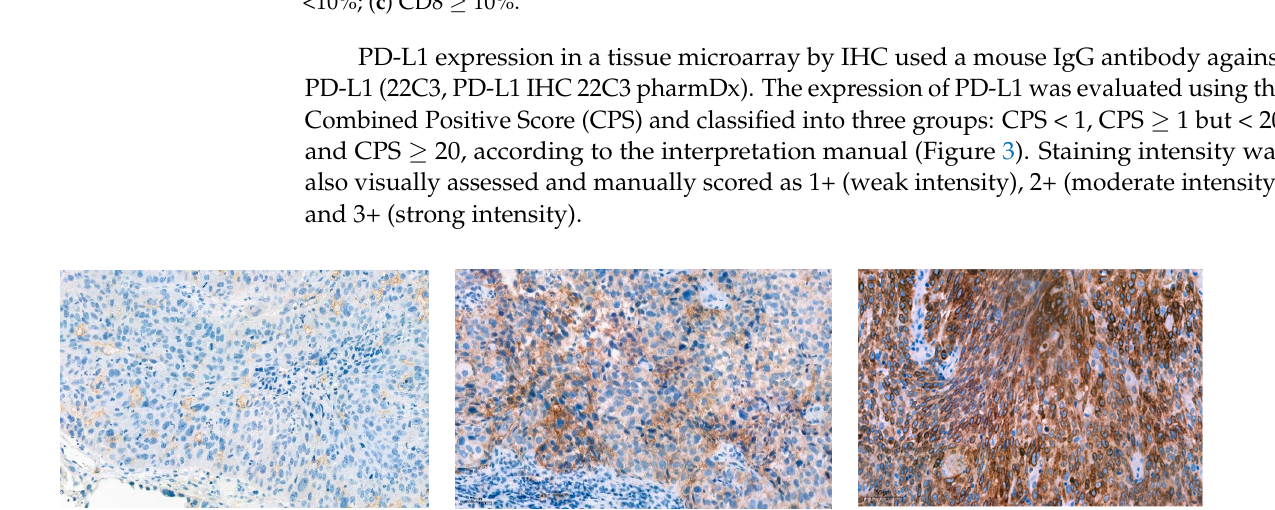
Figure 3 . Immunohistochemical staining for PD - L1 ( 200× ). ( a ) CPS > 1 but < 20 with weak intensity ( 1 +) ; ( b ) CPS > 20 with moderate intensity ( 2 +) ; ( c ) CPS > 20 with strong intensity ( 3 +).